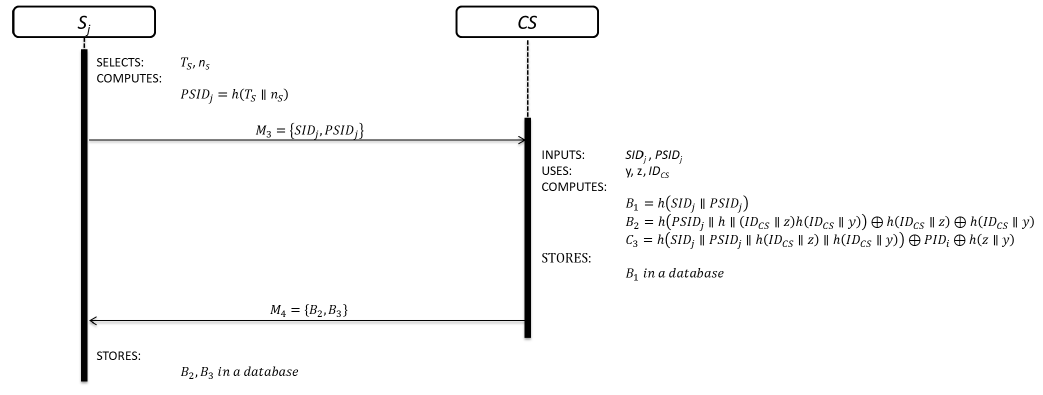
Figure 3. Server registration sub-phase.